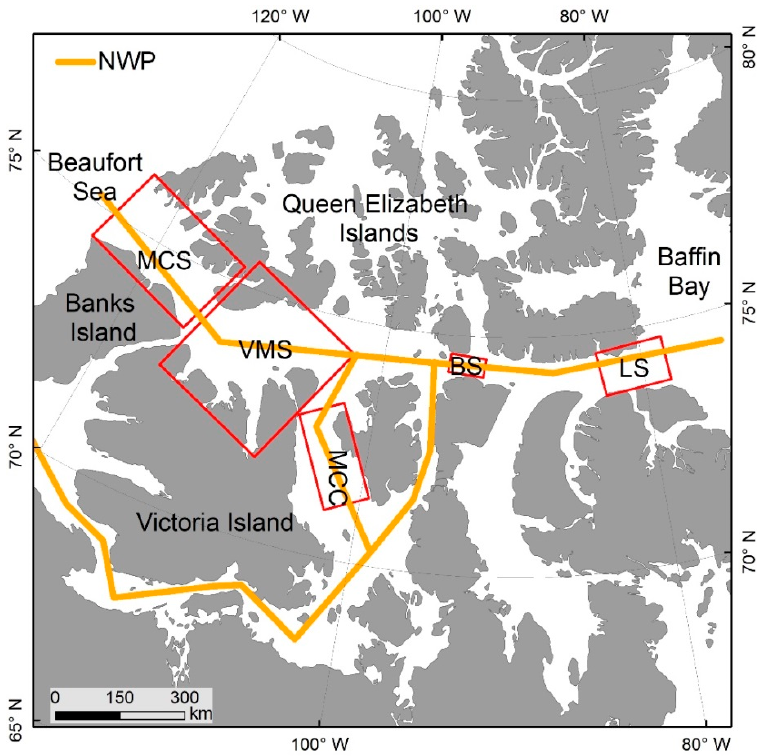
Figure 1. Study area with possible routes of NWP (solid lines) and the five straits and channels used in the study. Red frames are the shapes of the desired straits for clipping. The continent and islands are presented with grey.